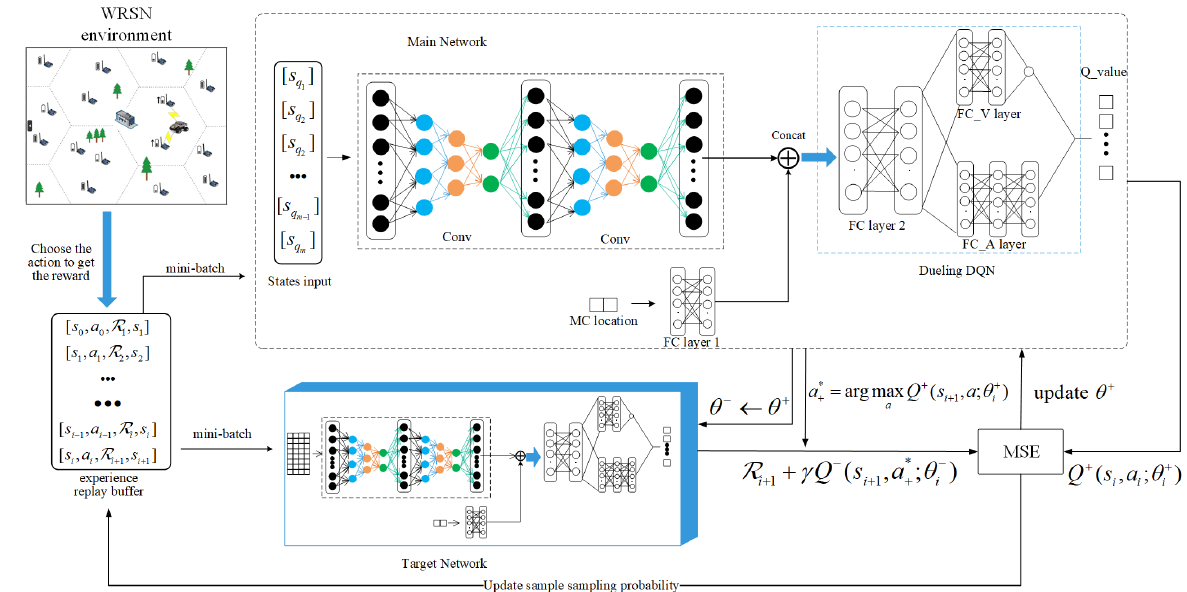
Figure 5. Network model structure of the